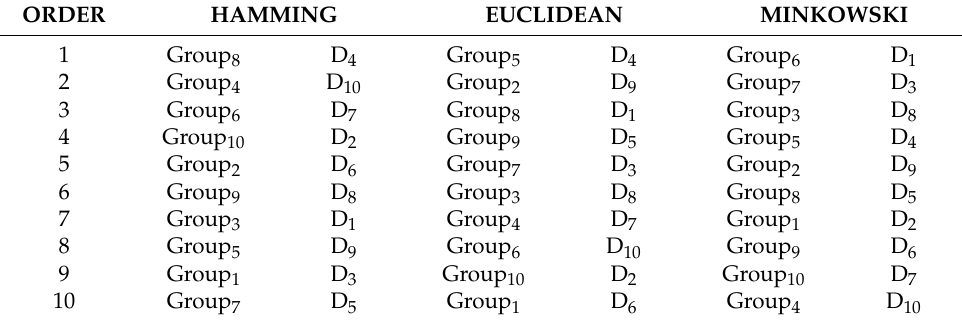
Table 13. Assignation process.